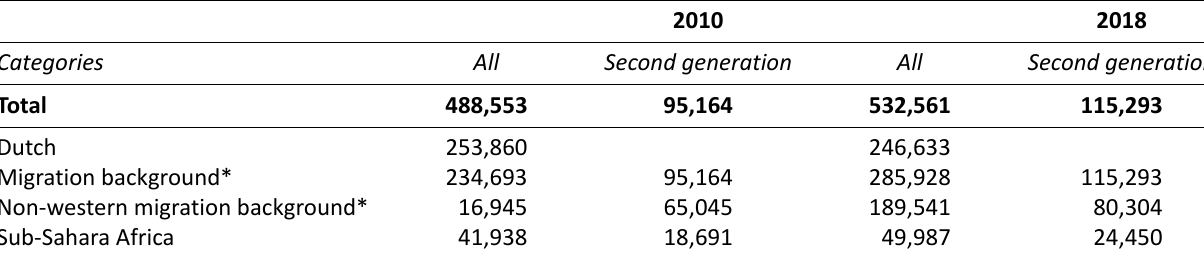
Table 1. Population backgrounds in The Hague municipality, 2010–2018. Source: CBS